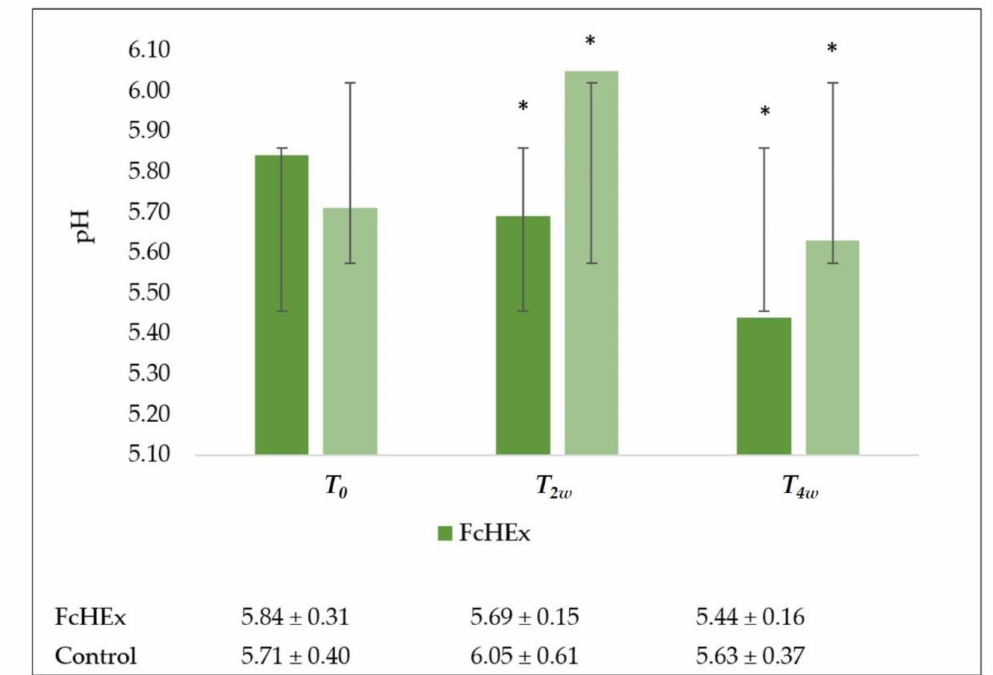
Figure 13. Skin pH evaluation. The skin pH trend values at time T 0 (time of application), T 2w (after two weeks—acute stress), and T 4w (after four weeks—recovery effect). All the measures for T 2w vs. T 0 and T 4w vs. T 0 for the FcHEx and the control were statistically significant. The asterisks indicate statistically significant values (* p -value was between 0.01 and